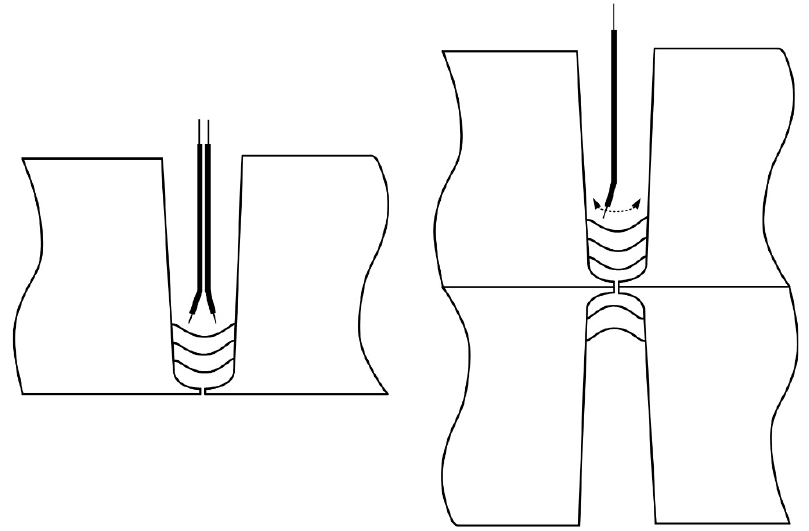
Figure 1. Schematic of the welding processes.